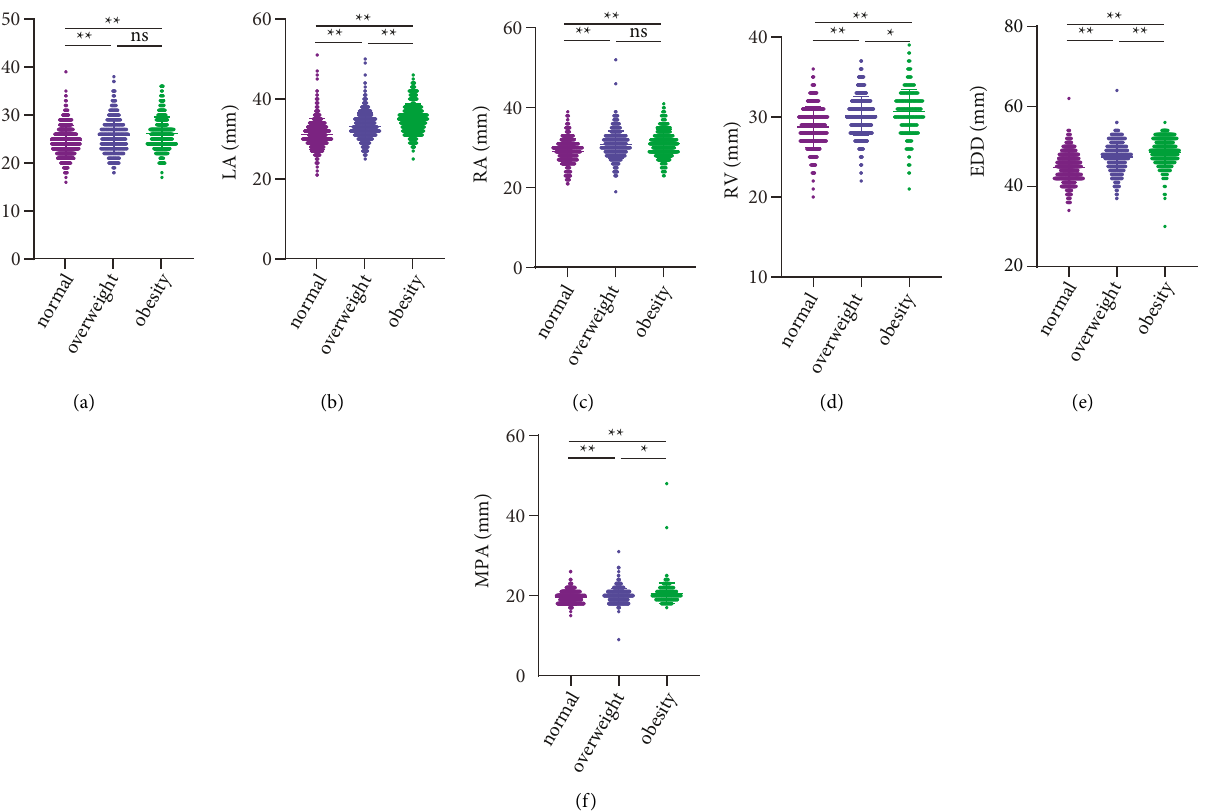
Figure 1: Comparison of cardiac ultrasound indices in normal, overweight, and obese populations. (a) Aorta (AO). (b) Left Atrium (LA). (c) Right Atrium (RA). (d) Right Ventricle (RV). (e) End Diastolic Diameter of Left Ventricle (EDD). (f) Main Pulmonary Artery (MPA). ∗∗ P < 0 . 001. ∗ P < 0 . 05 ns P > 0 .